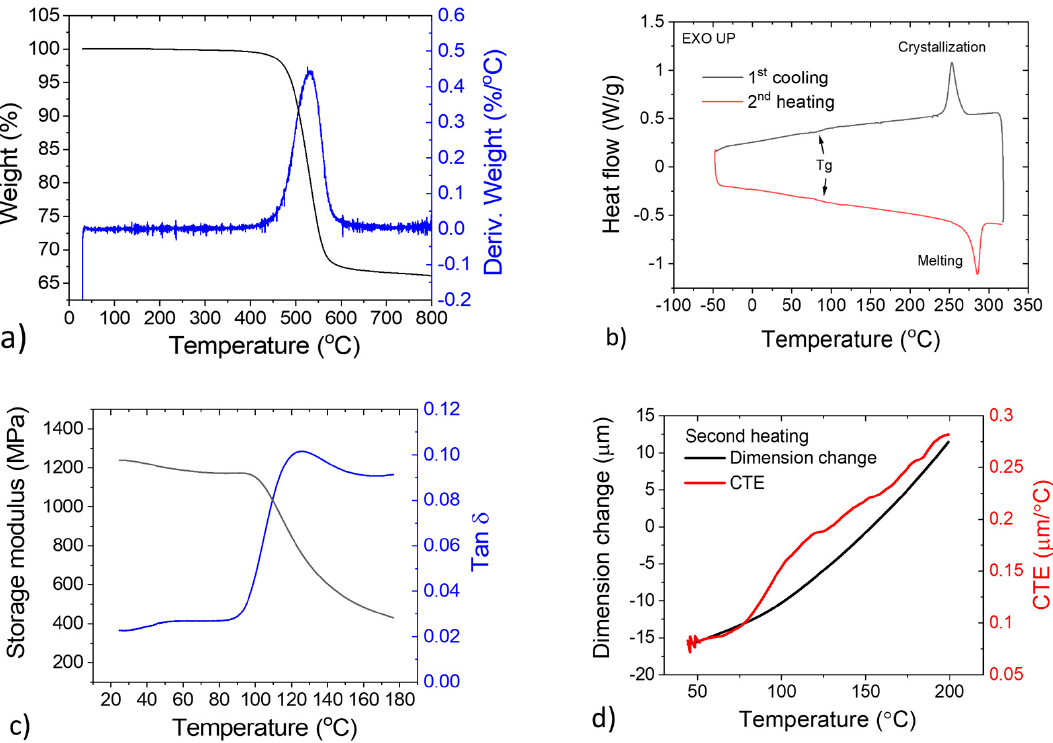
Figure 4. Thermal analysis of the polymer heat exchanger. ( a ) TGA curve showing a maximum decomposition rate around 531 °C; ( b ) DSC curve showing a T g of 87.6 °C and a T m of 285.6 °C; ( c ) DMA oscillation showing the evolution of storage modulus and tan δ with temperature; and ( d ) TMA curve showing excellent dimensional stability of the polymer compo- site.